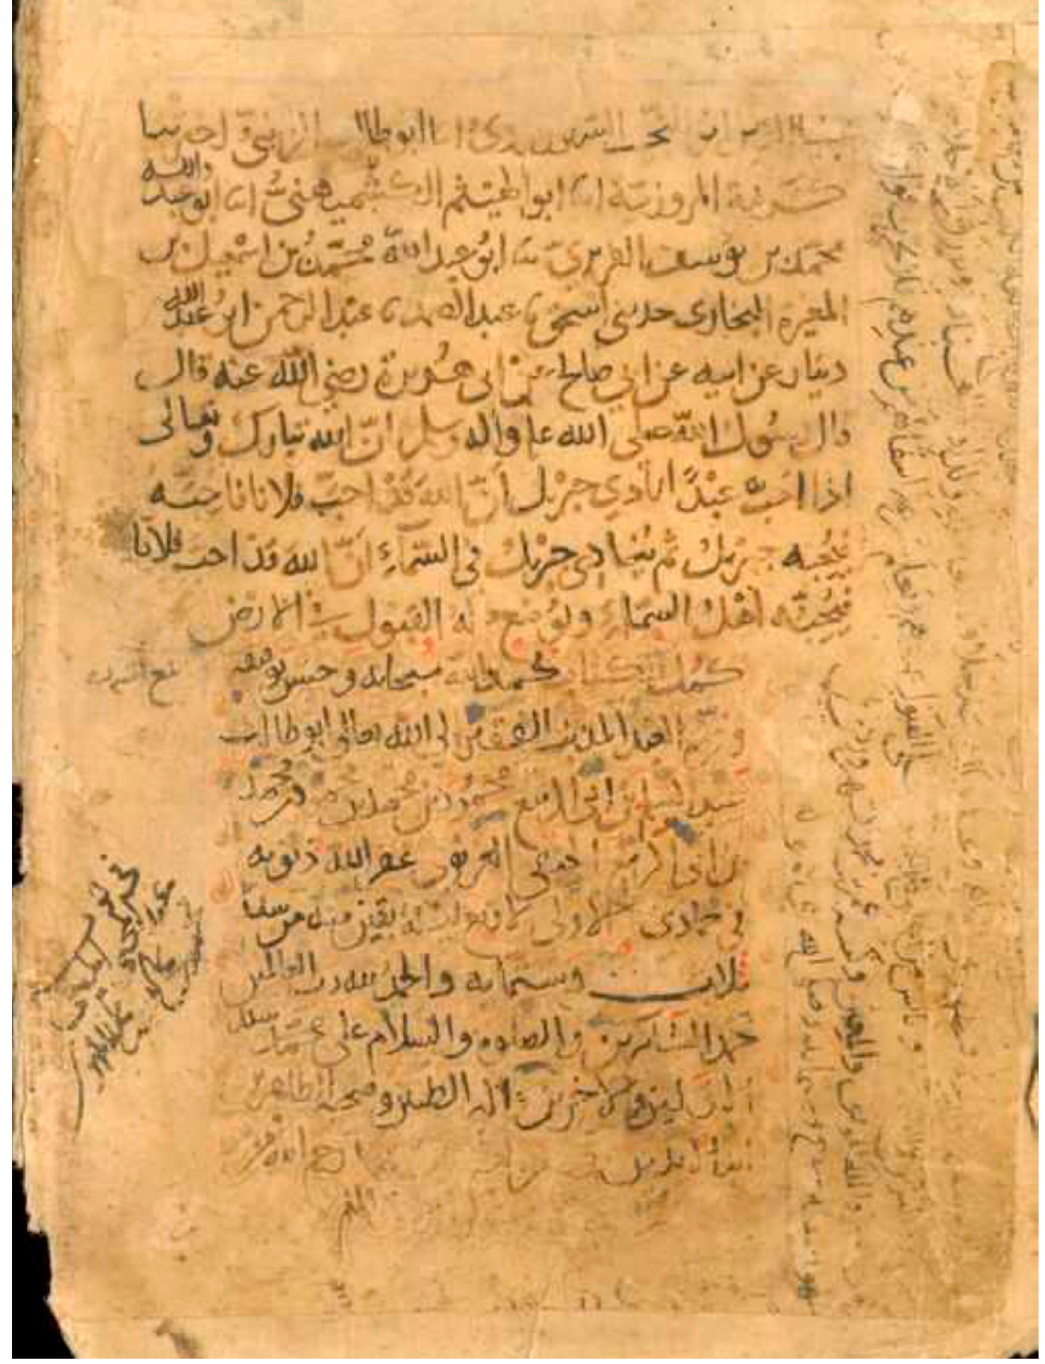
Figure A1. MS Belgrade O.1115, f.264b (colophon, with al-Suhraward¯ı’s handwriting on the right margin).